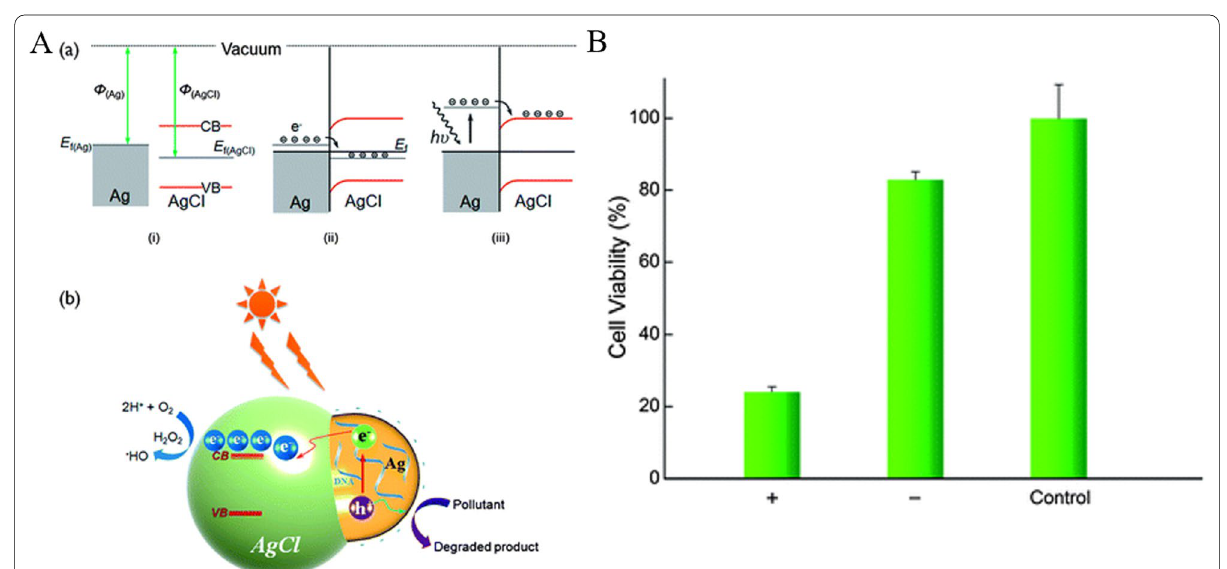
Fig. 2 A Illustration of the plasmonic Ag/AgCl nanostructure-based photocatalytic reaction mechanism. The DNA capping makes silver nanostructures negatively charged. B A comparison of viability among HeLa cells incubated with ( in PBS after photo-irradiation for 8 min. Adapted from Ref. [111] with permission. Copyright (2013), Journal of Materials Chemistry B